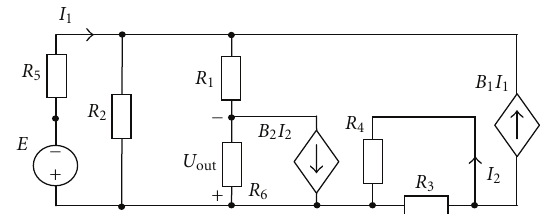
Figure 2: The linearized equivalent network of a transistor